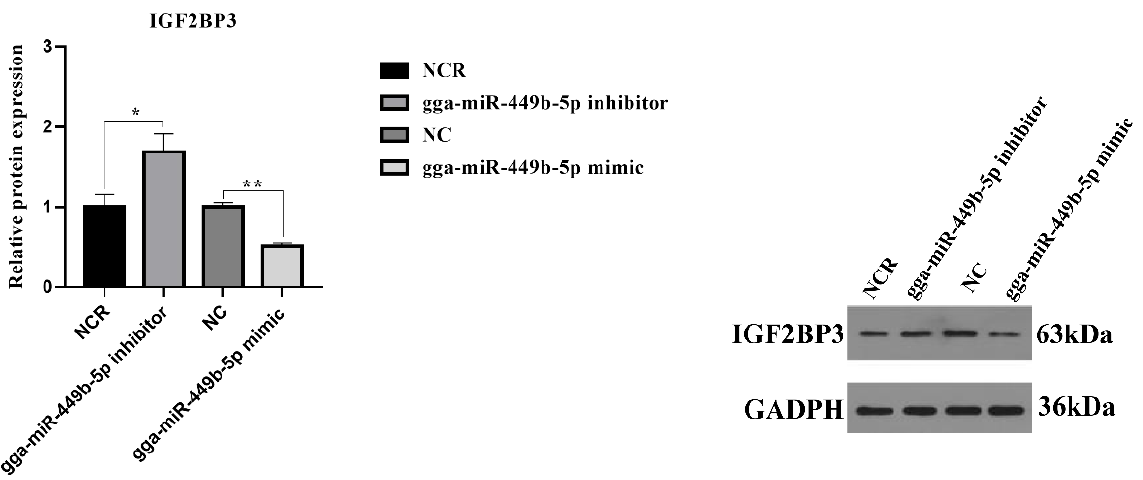
Figure 5. The protein expression of IGF2BP3 in GCs of small yellow follicles (6 − 8 mm) transfected with gga-miR-449b-5p mimic or inhibitor. ** and * indicated that there were significant differences ( p < 0.01) and significant differences ( p < 0.05),